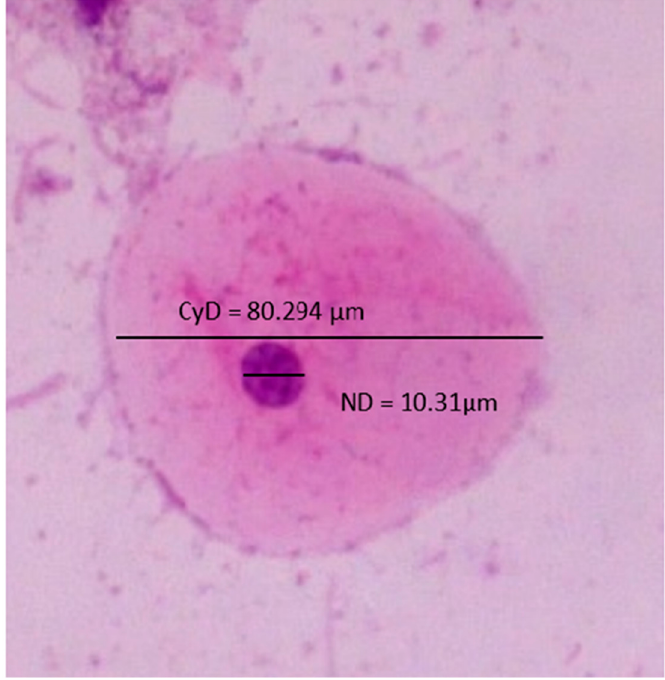
Figure 1. Cytological smear showing nuclear and cytoplasmic diameters.